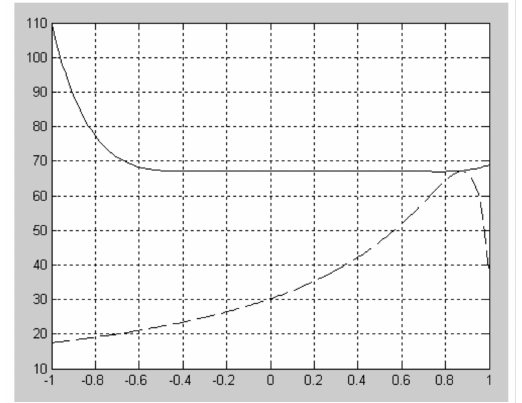
Figure 10. Optimal tip profile corresponding to F 4 = 140 cm 2 and k 4 =